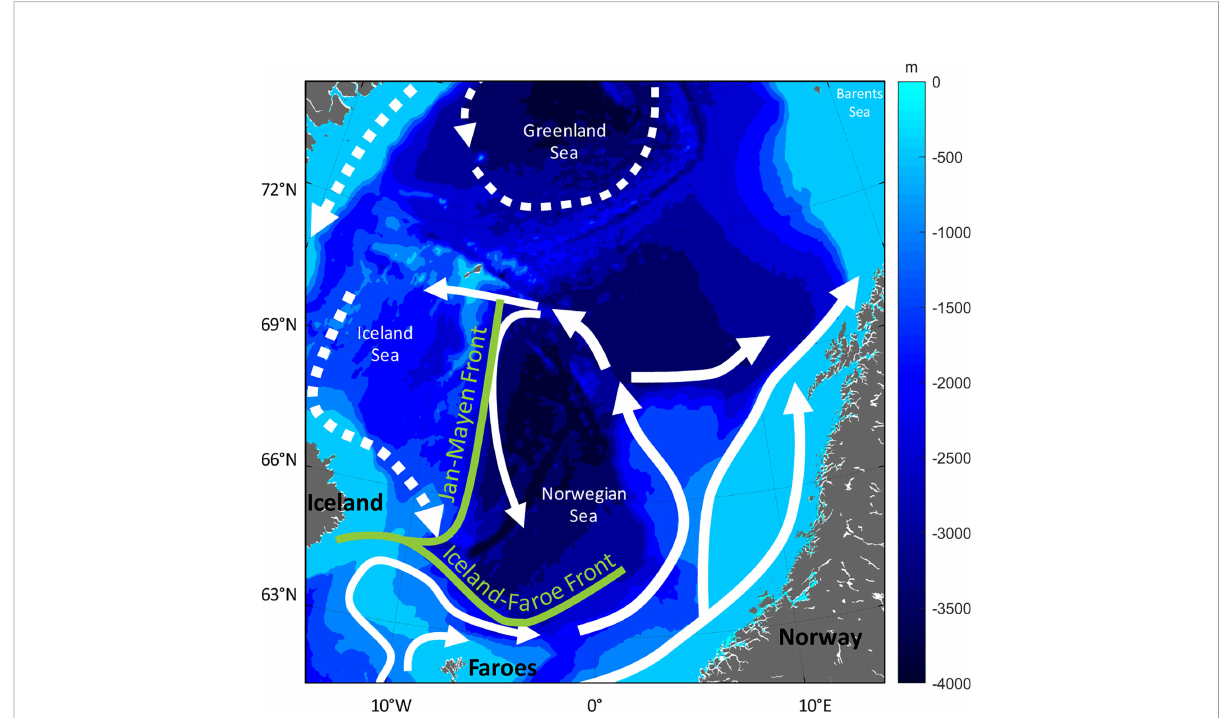
FIGURE 2 Map of the Norwegian Sea and surrounding waters. Map overlaid with bottom depth and main currents (white arrows, dotted currents are cold water masses) and main fronts (green